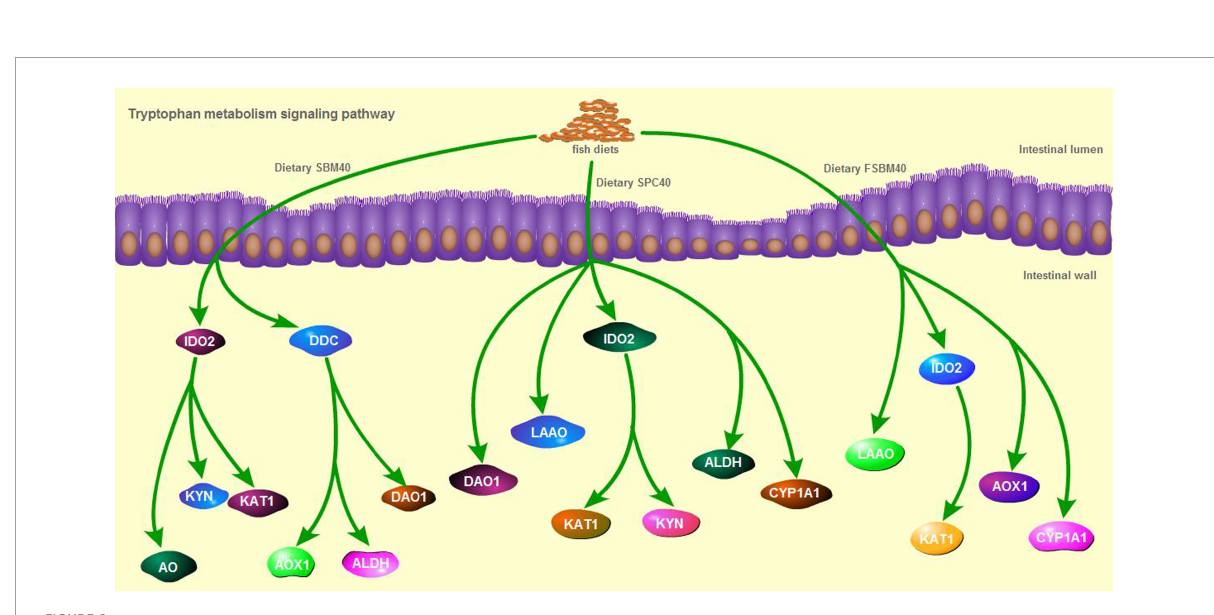
Frontiers in Nutrition